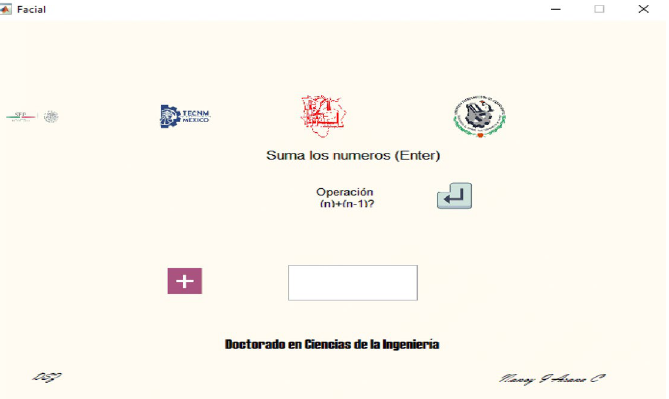
Figure 3. Mental Workload Graphical User Interface task window in Spanish.